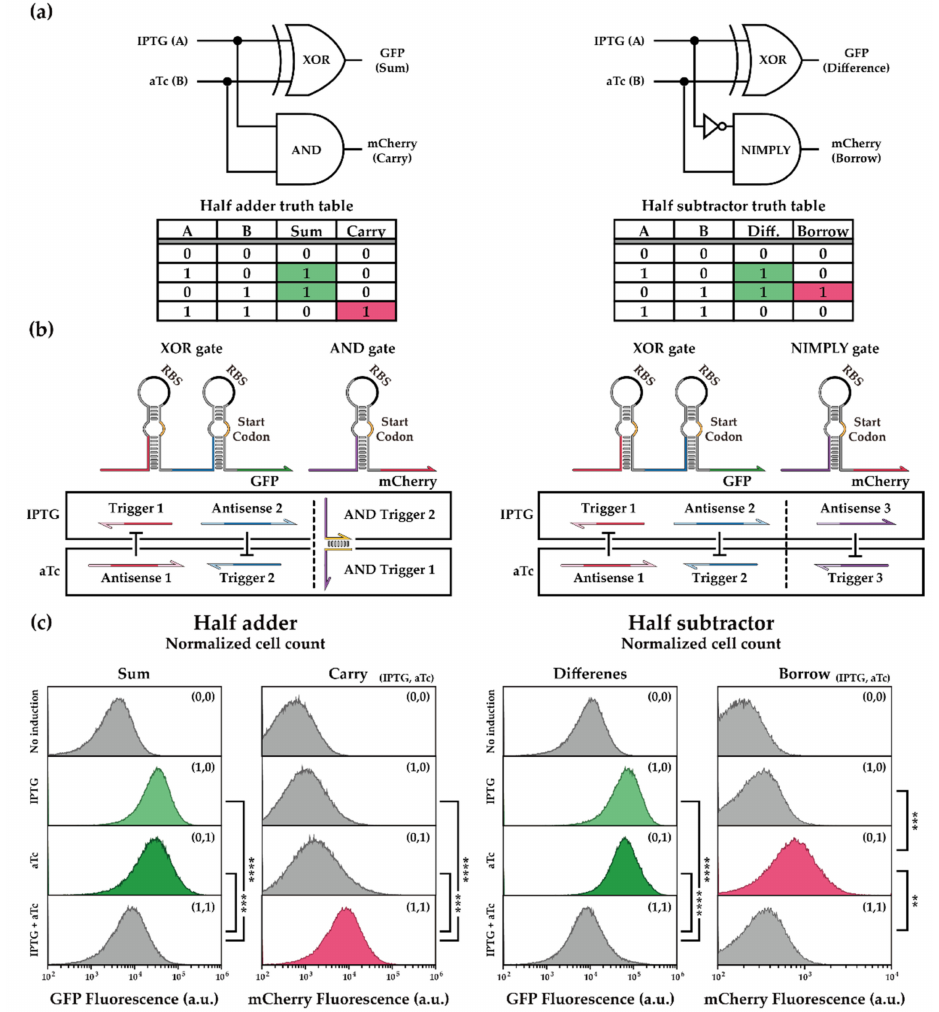
Figure 4. Binary operation of half adder and half subtractor. ( a ) Schematic of half adder and